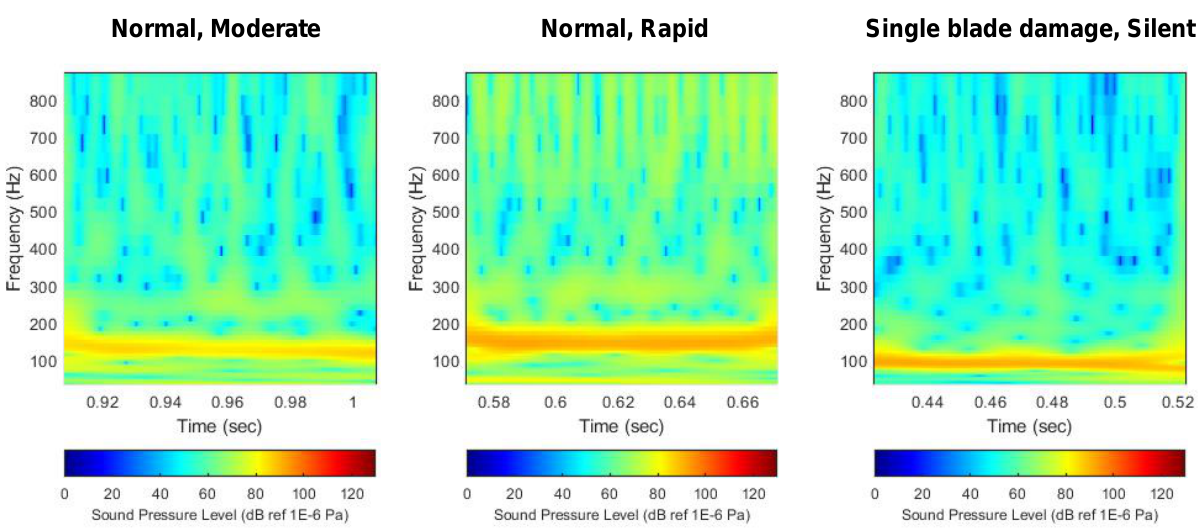
Figure 14. Flow noise scalogram for off-training condition with decibel scale. ( left ) Normal–moderate; ( middle ) normal–rapid; ( right ) single-blade